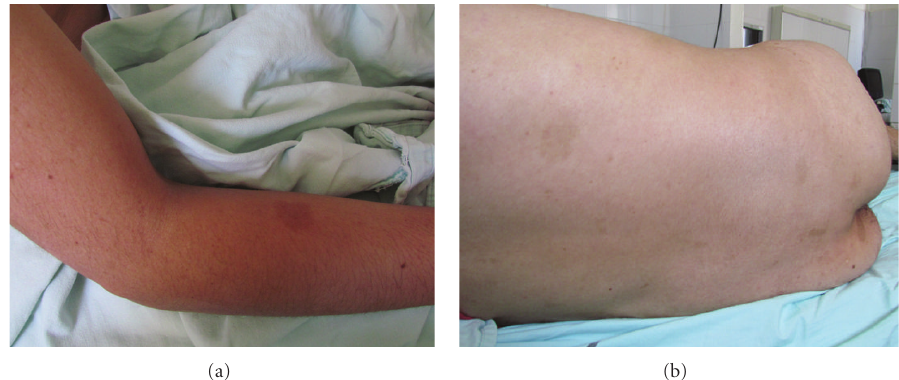
Figure 1: Photograph of the patient skin. It shows multiple caf´e- au- lait macules on the anterior arm side (a) back of 5 × 3cm and buttocks (b).